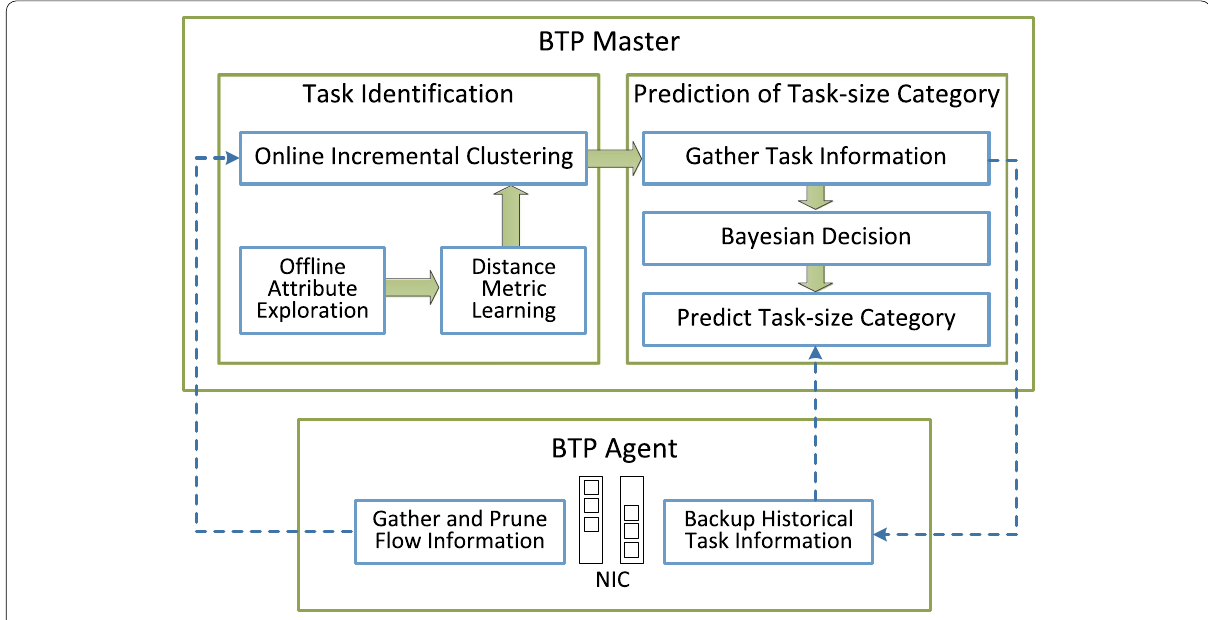
Fig. 1 The architecture of